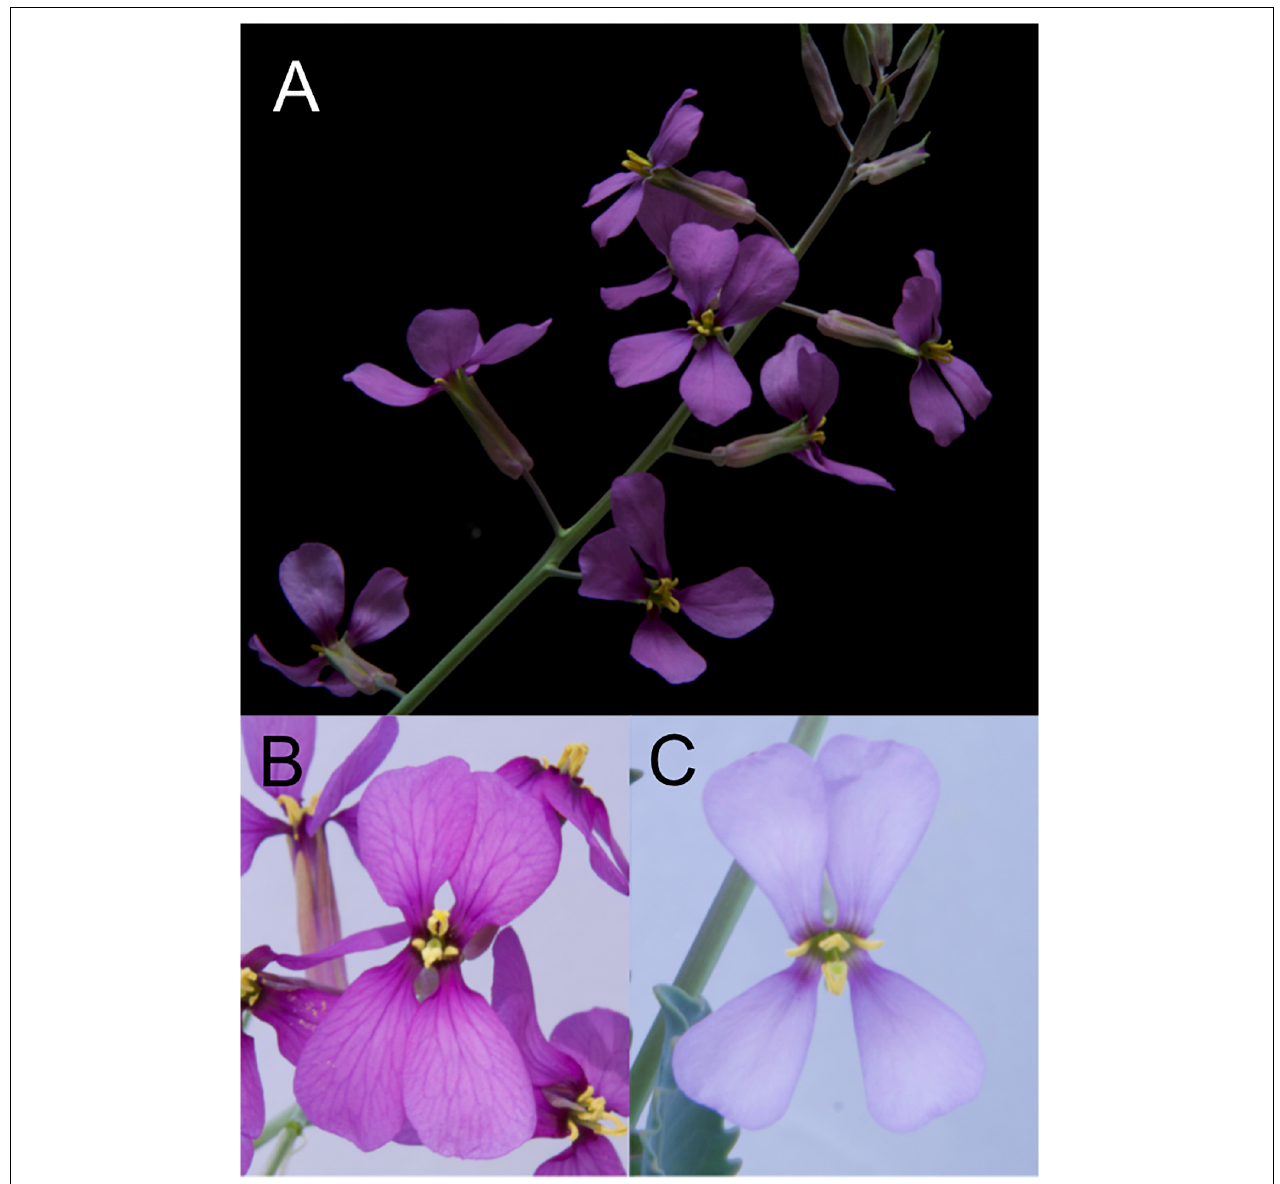
FIGURE 1 | The floral display of Moricandia moricandiodes (A) . (B,C) show sampled flowers with contrasting petal